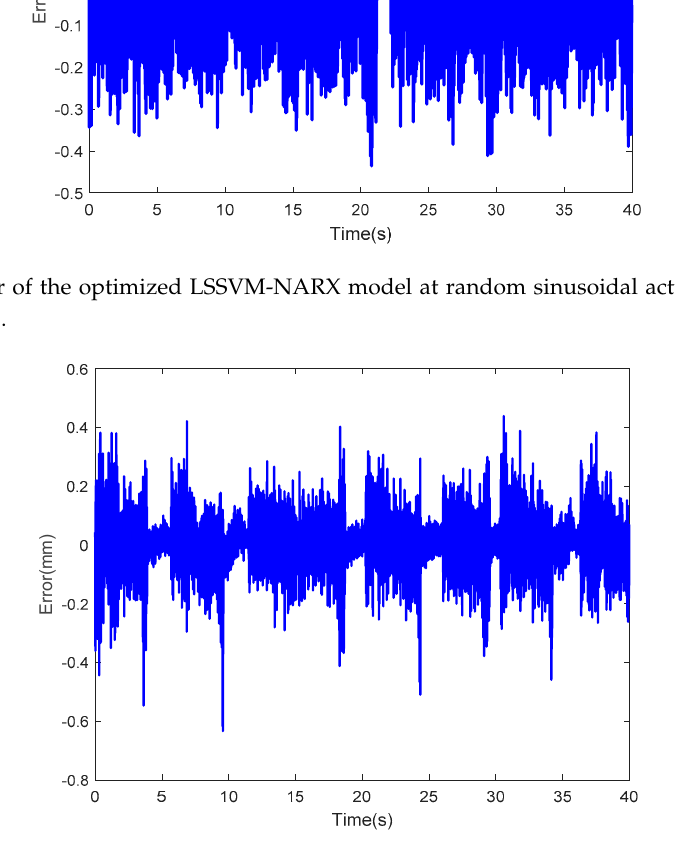
Figure 38. Error of the optimized LSSVM ‐ NARX model at random sinusoidal actuating voltage II (RMSE = 0.0941).